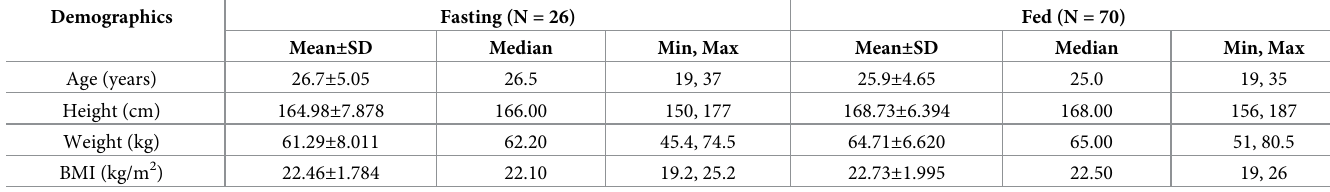
Table 1. Demographic characteristics of the healthy Chinese volunteers in fasting and fed